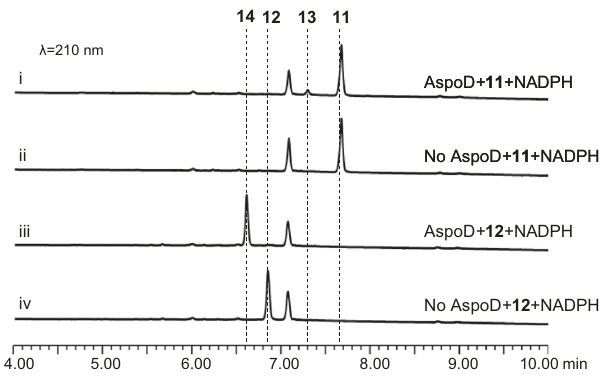
Fig. 7 Con fi rmation of the function of AspoD. In vitro biochemical assays showed that AspoD catalyses the reduction of 11 or 12 to 13 or 14 ,